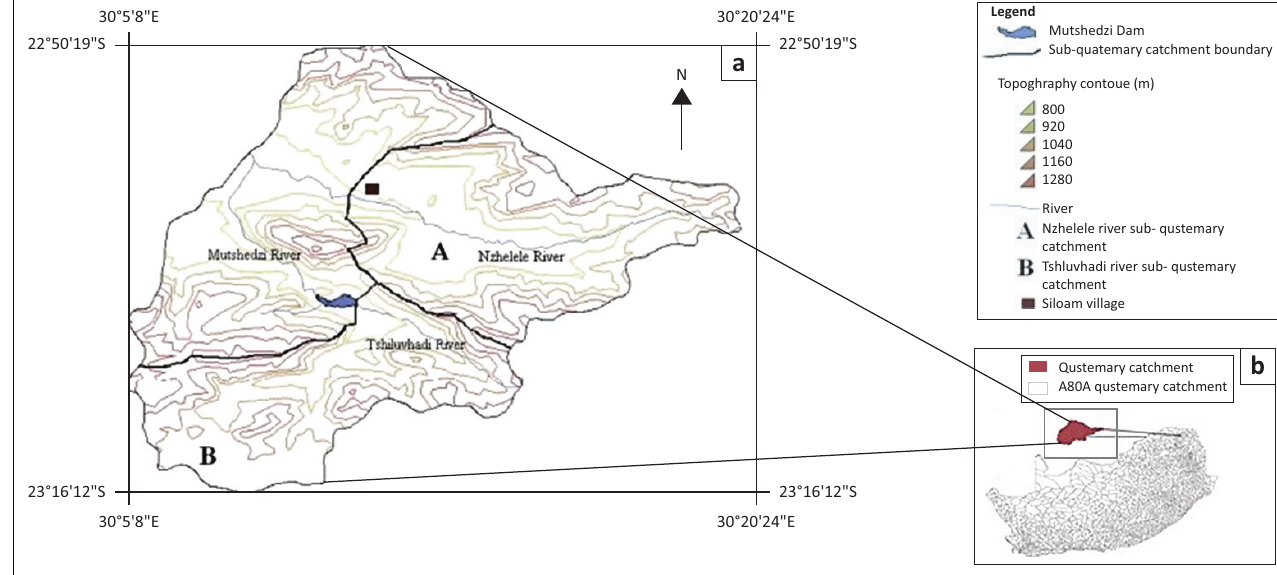
FIGURE 2: Map of (a) Siloam village in Nzhelele catchment, Limpopo, (b) South Africa.